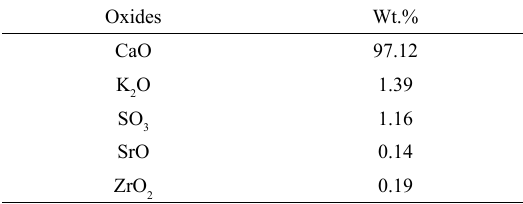
Table 2. Chemical analysis of eggshell waste.